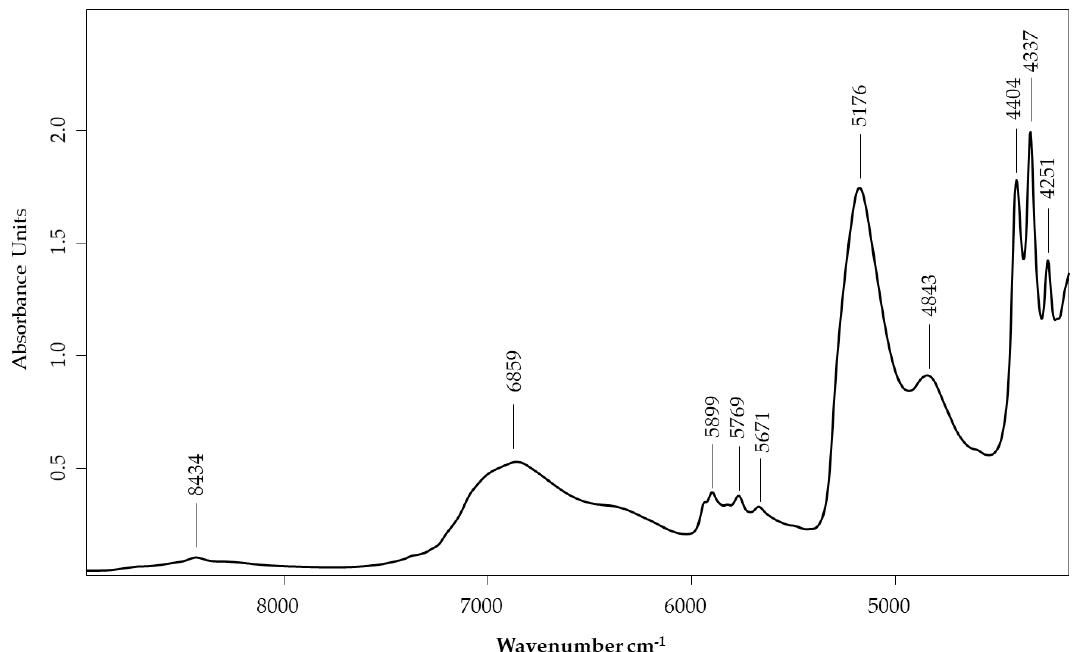
Figure 2. Absorption spectra of a representative wine spirit sample in near infrared region measured against a background of air.